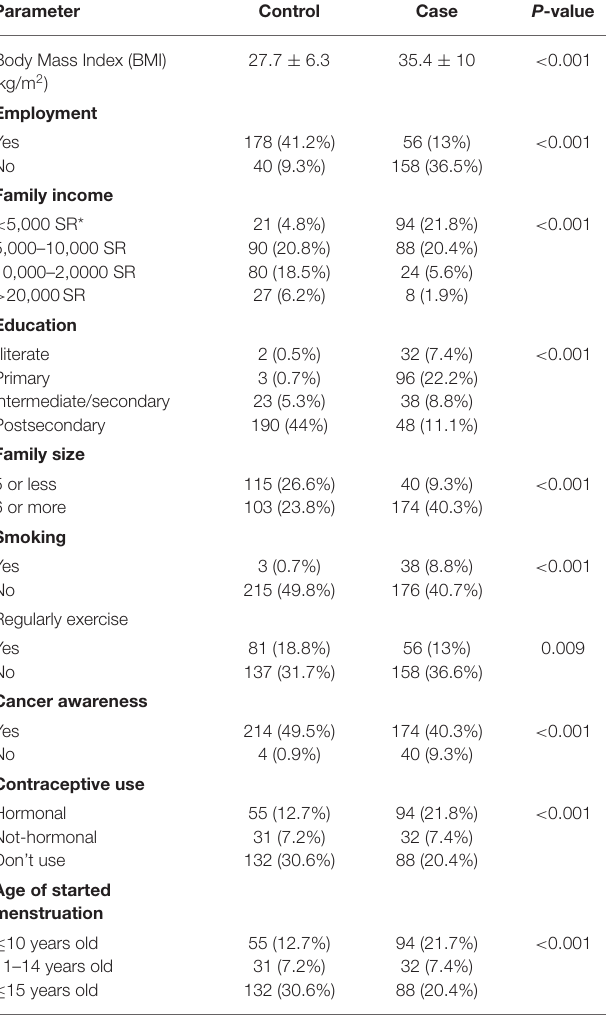
TABLE 1 | Baseline characteristics of the participants ( n = 432 total). TABLE 2 | Dietary habits for the main food groups between the case and control